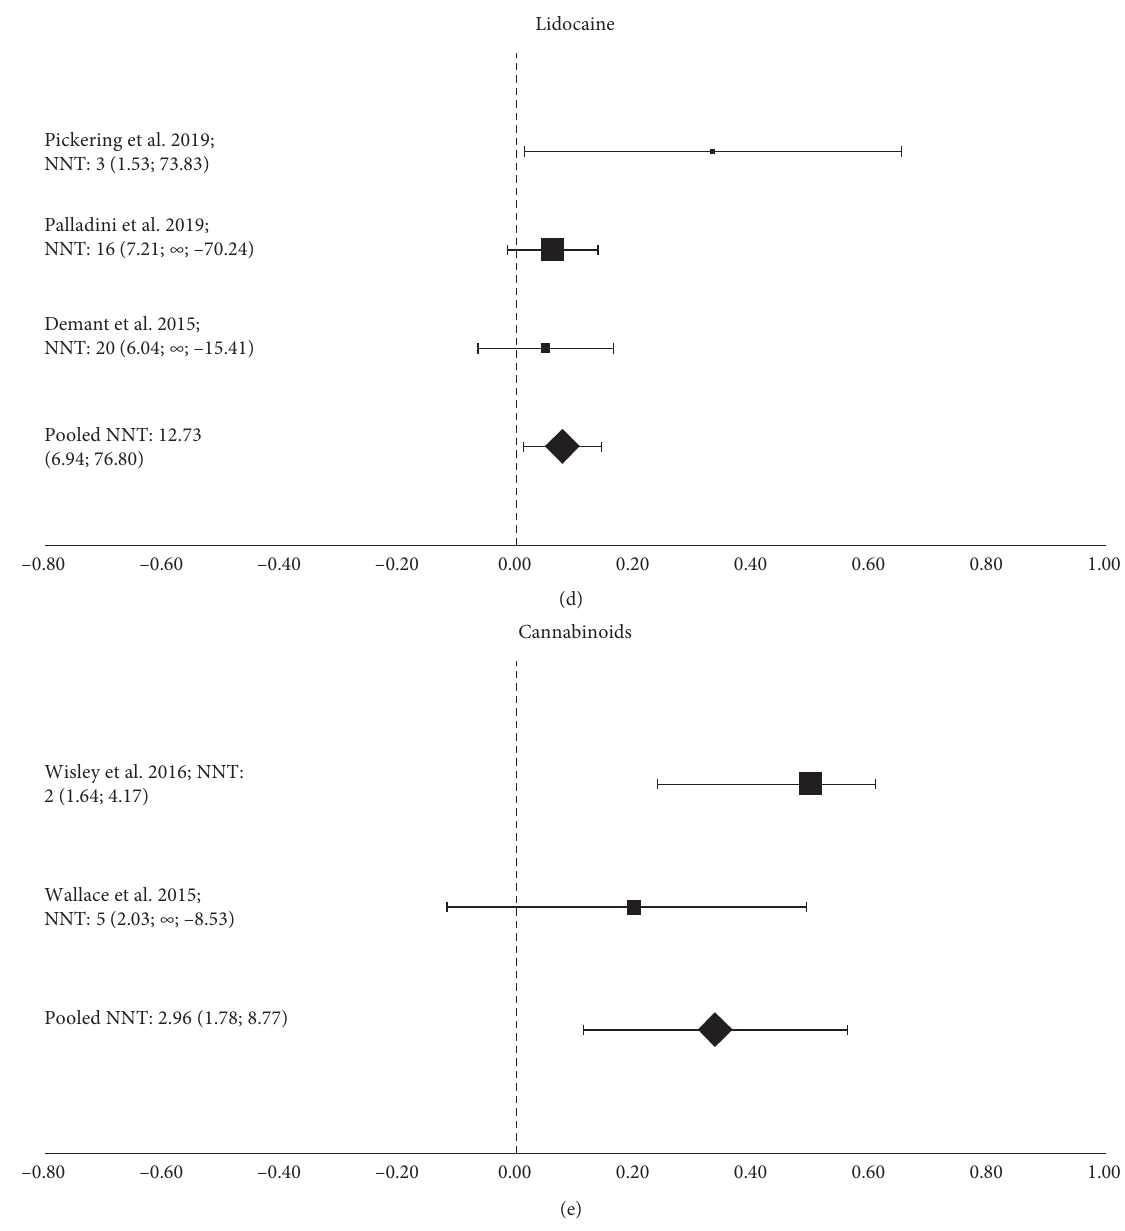
Figure 2: Forest plots of randomised controlled trials included in the metanalysis. Each value is expressed as mean NNT (95%